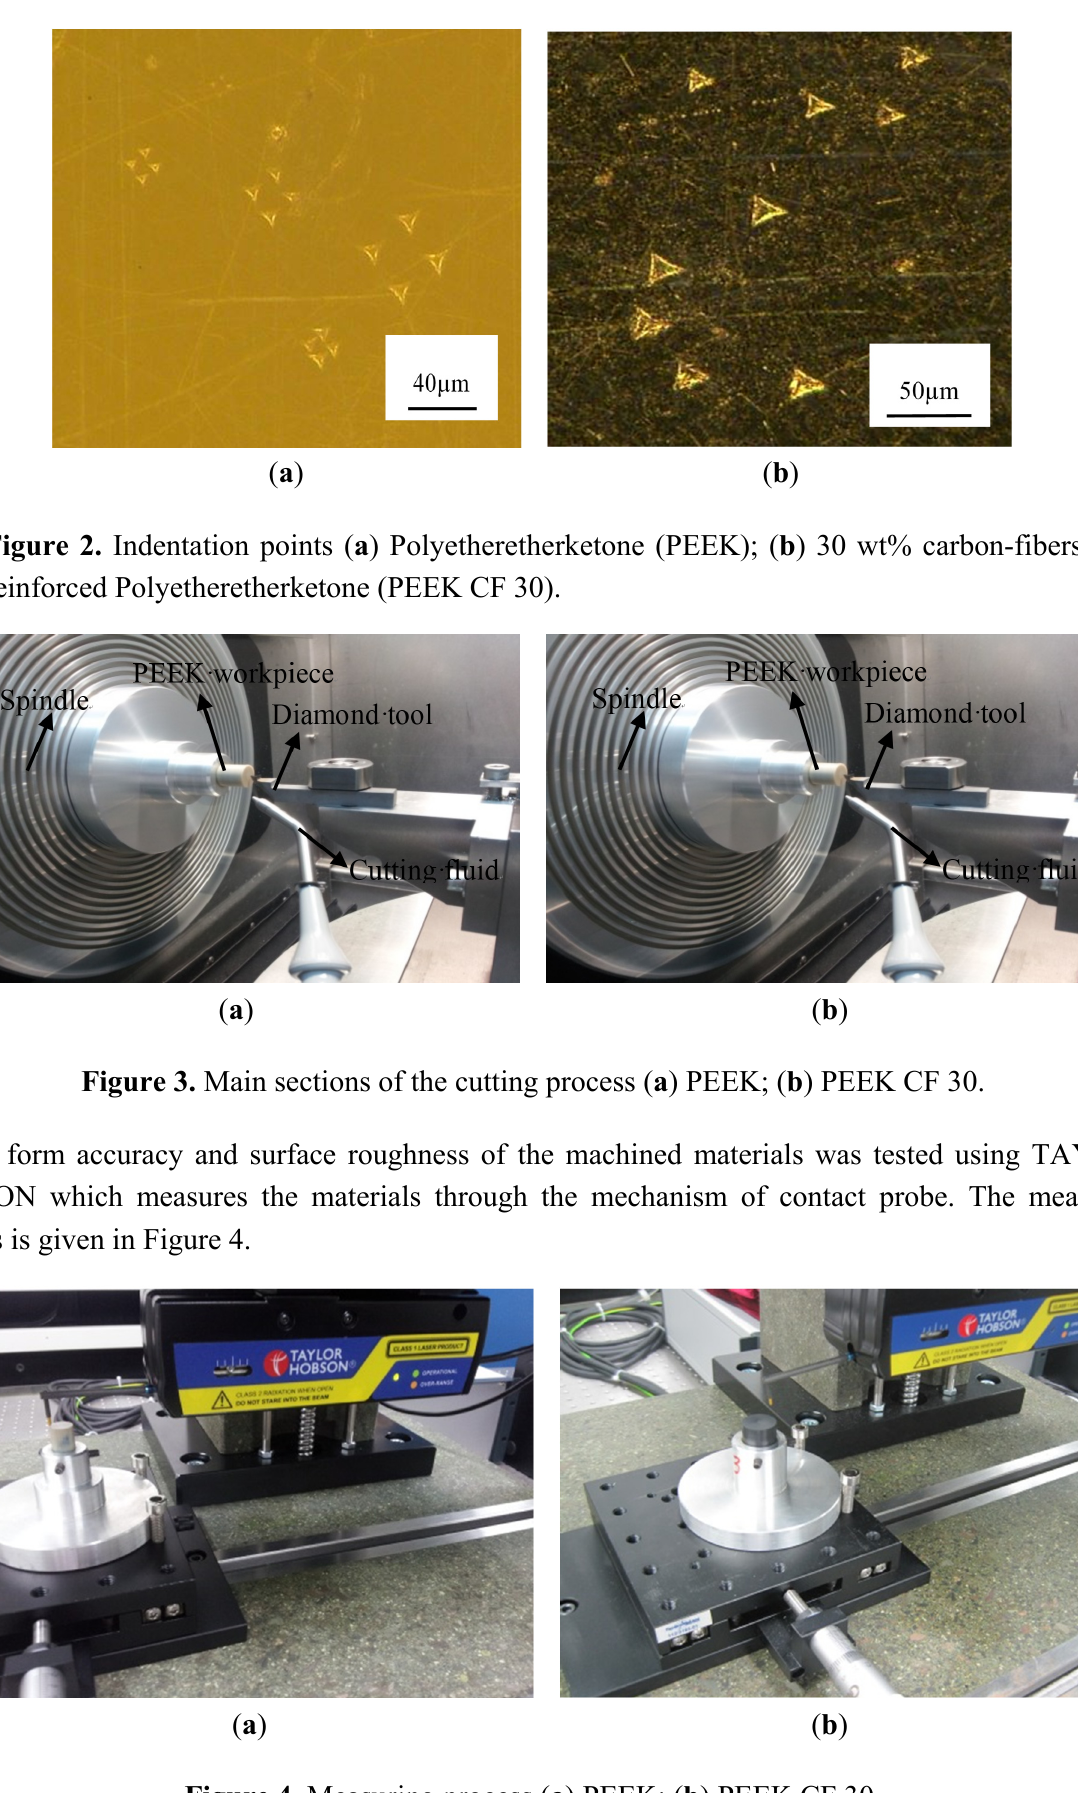
Figure 4. Measuring process ( a ) PEEK; ( b ) PEEK CF